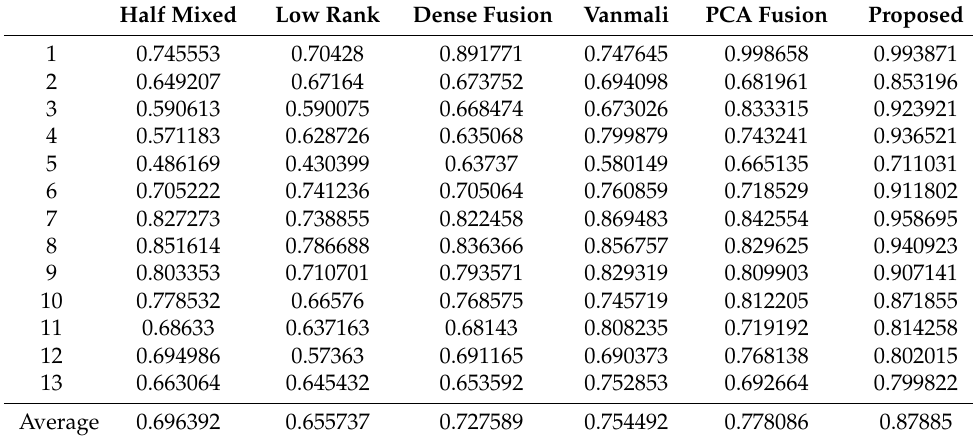
Table 2. Comparison of the VIFF metrics.